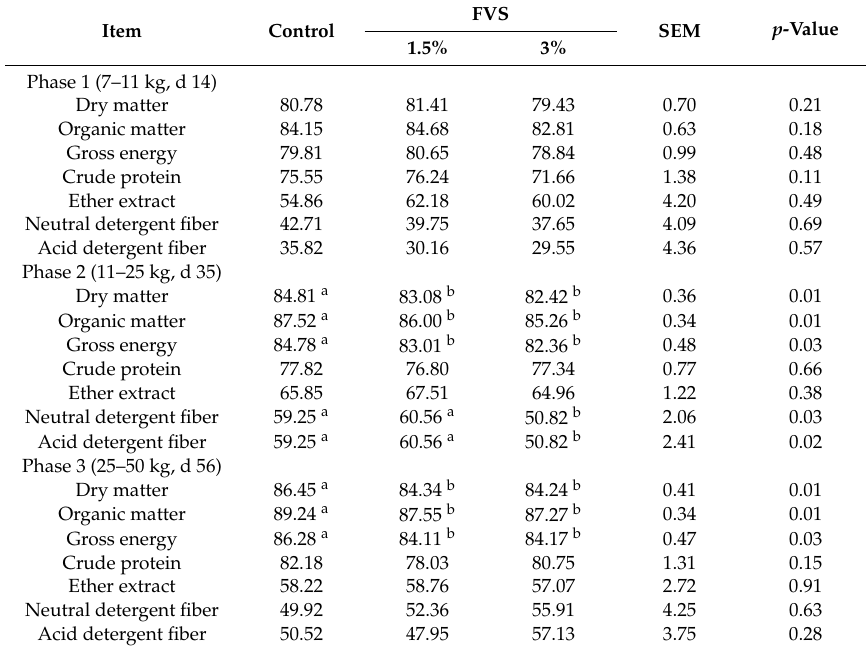
Table 8. E ff ects of Flammulina velutipes stem waste (FVS) supplementation in diets fed to weaned